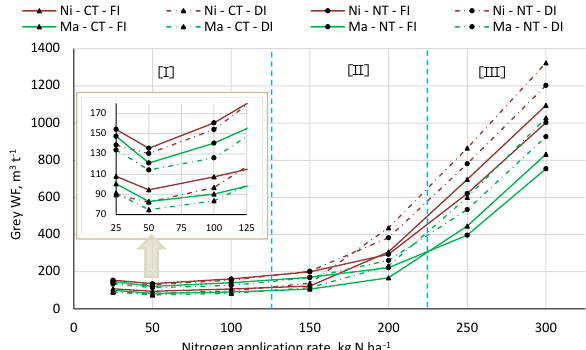
Figure 4. The effect of N application rate, N form, tillage prac- tice and irrigation strategy on grey WF per tonne. Considering